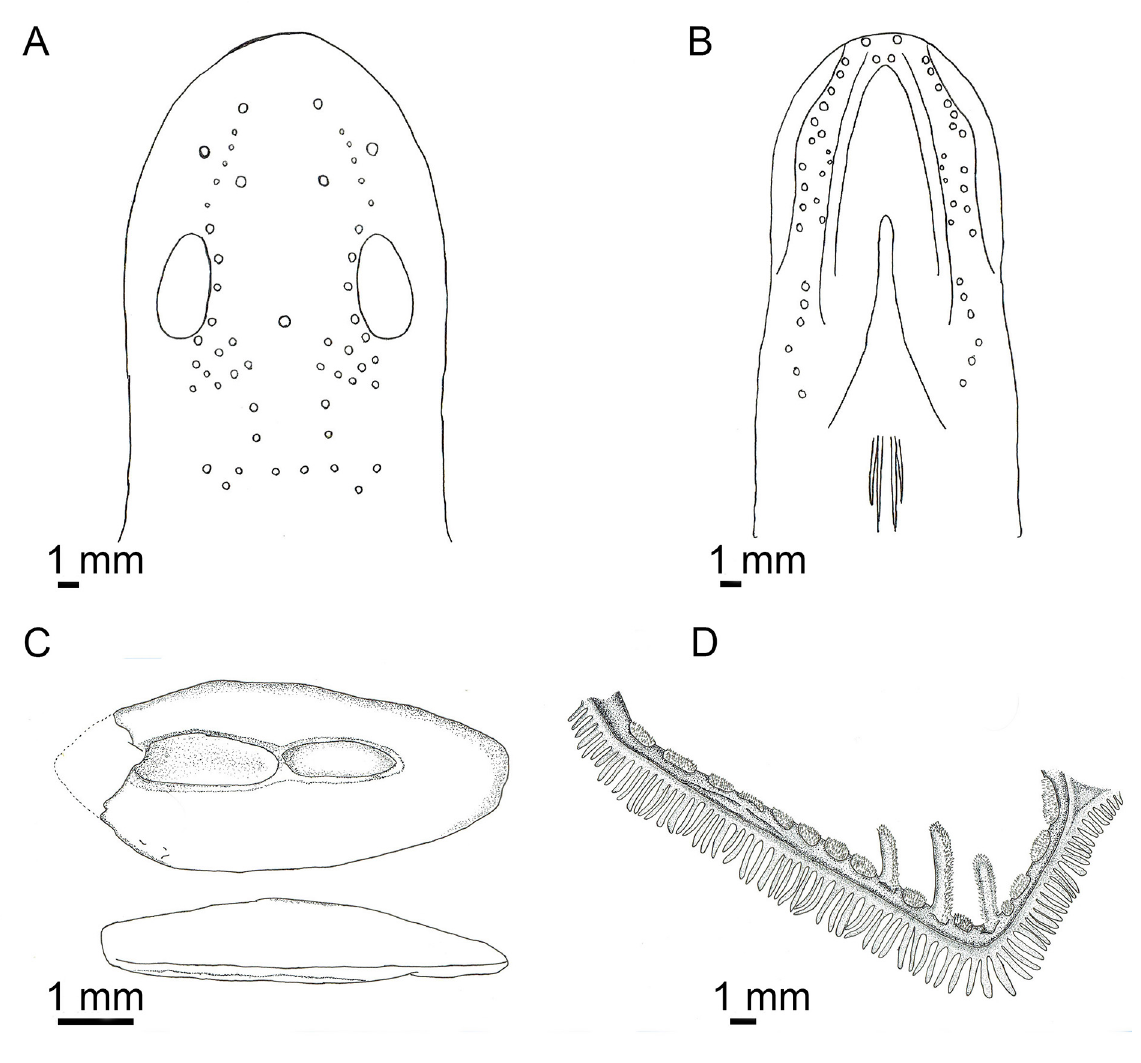
Fig. 4. Luciobrotula polylepis sp. nov., holotype (NTUM 11915). A . Dorsal view of sensory pores on head. B . Ventral view of sensory pores on head. C . Median and ventral view of right sagitta. D . First gill raker (left